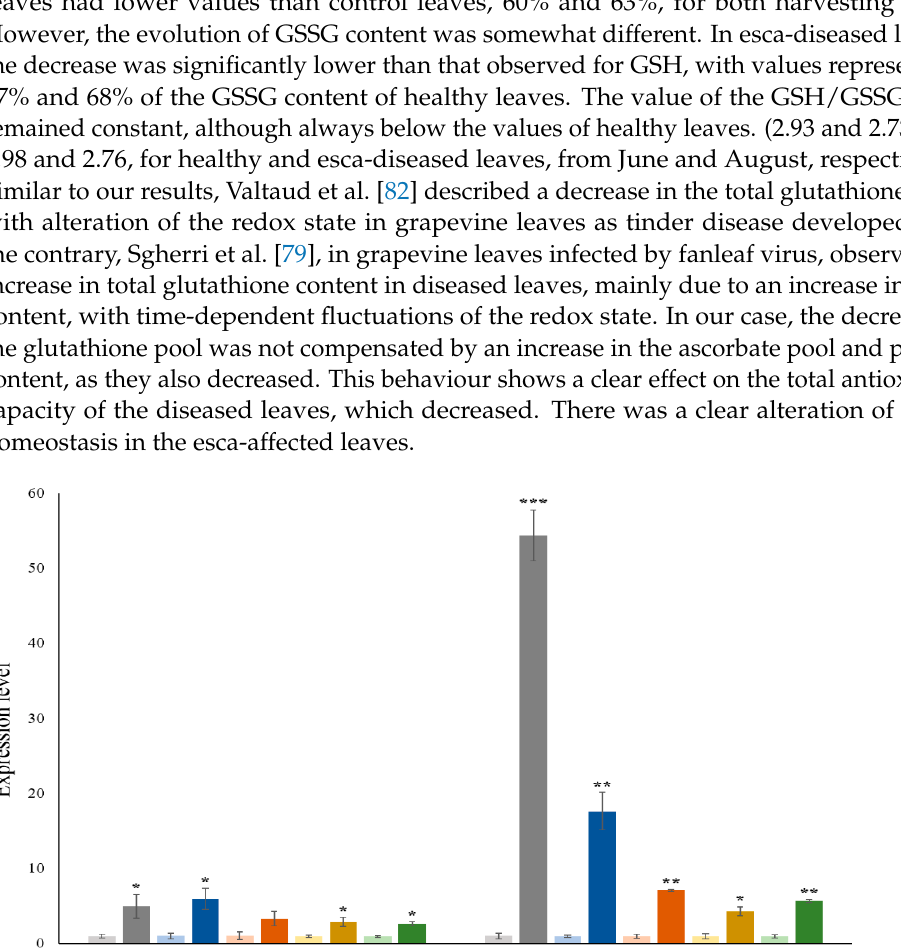
Table 6. Effect of esca on the AsA, DHA, and ascorbate pool (AsA + DHA) contents, and the AsA/DHA ratio, the GSH, GSSG, and glutathione pool (GSH + GSSG) contents, and the GSH/GSSG ratio, in grapes of Vitis vinifera cv. Tempranillo.